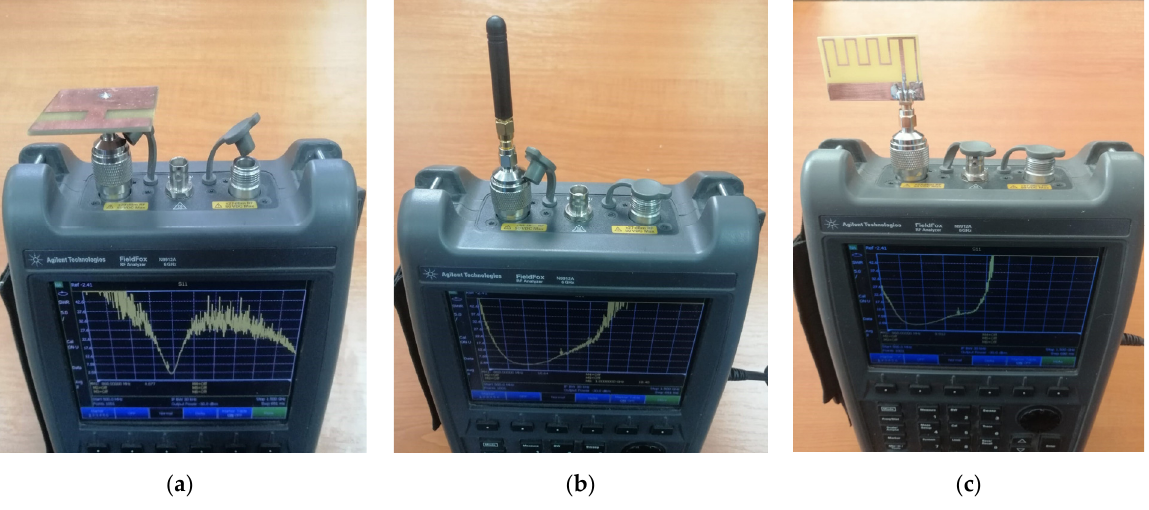
Figure 13. The proposed test setup: ( a ) proposed novel IoT antenna; ( b ) reference omnidirectional antenna; ( c ) reference microstrip antenna.